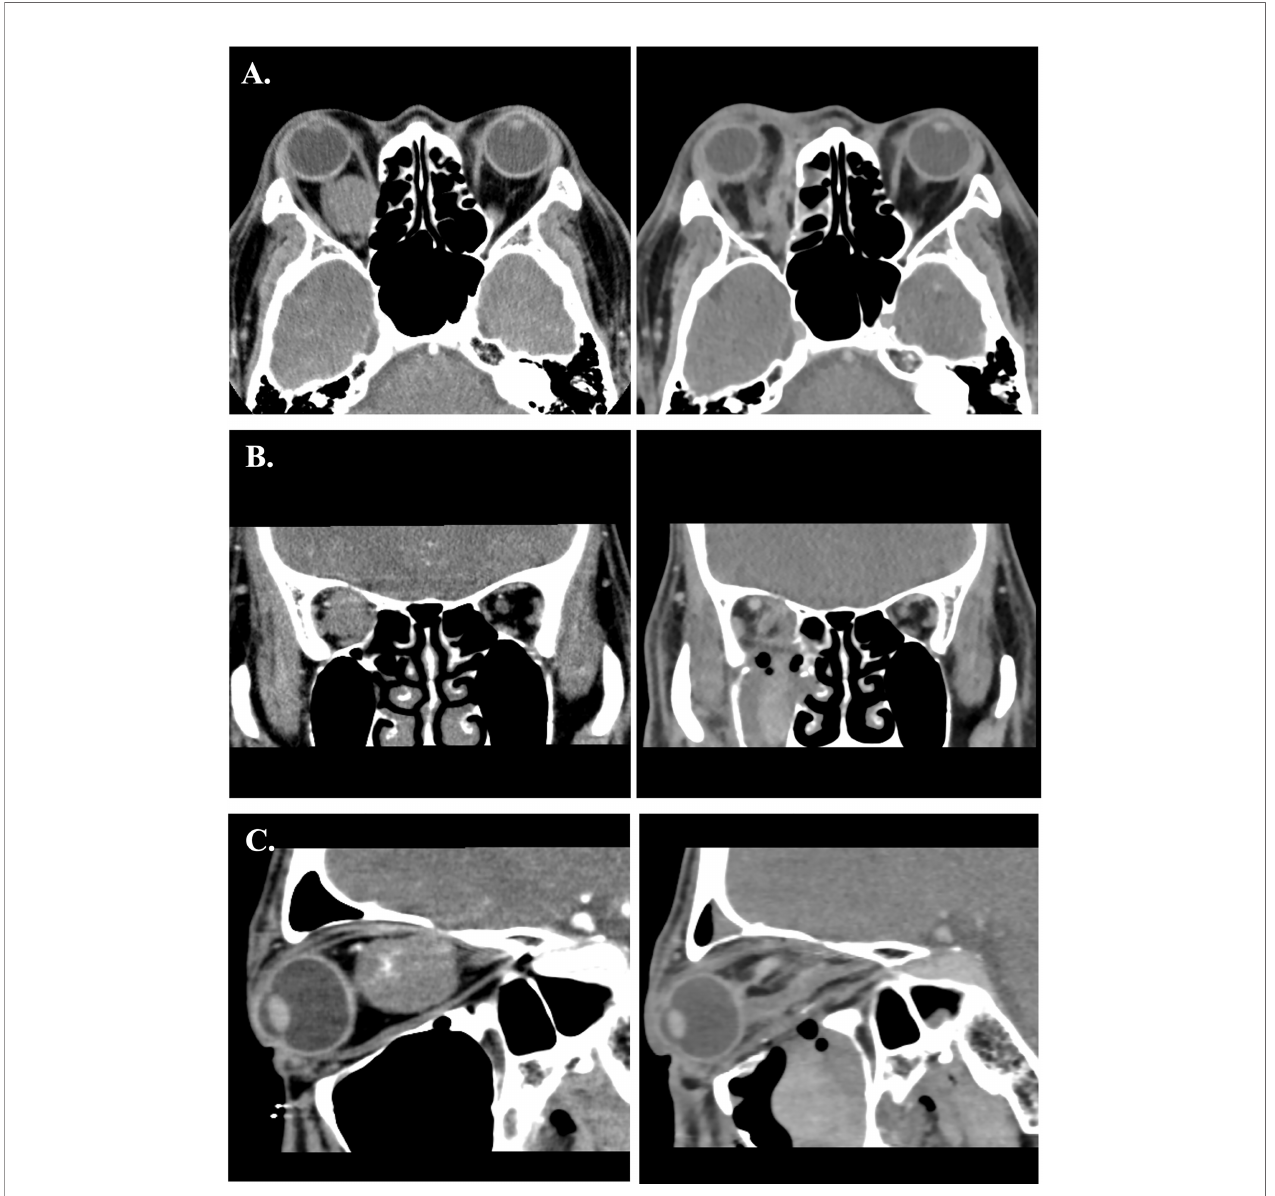
FIGURE 10 | (A – C) Preoperative and postoperative images of Case 4. The left side axial, coronal and sagittal images were the preoperative CT scans. The right- side immediate postoperative CT images showed swelling of the medial rectus and mild distortion of medial rectus